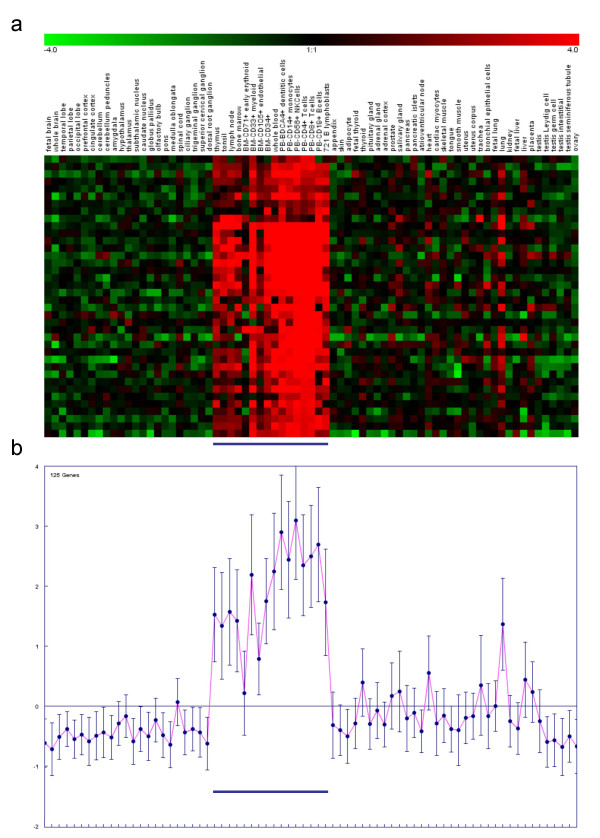
Gene expression patterns for a cluster of coexpressed genes with TE-derived HS sites. a) View of relative expression levels across conditions for a subset of cluster 2 genes, color coded according to over (red) and under (green) expression. b) Centroid view with cluster 2 expression averages.